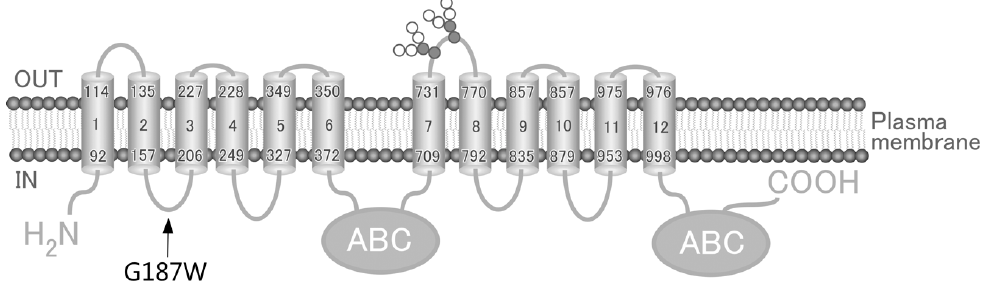
Figure 1. Schematic illustration of human ABCC4 and the location of SNP (rs11568658, 559 G > T, G187W). Arrow, location of SNP (rs11568658, 559 G > T, G187W); ABC, ATP binding cassette (nucleotide binding domain).